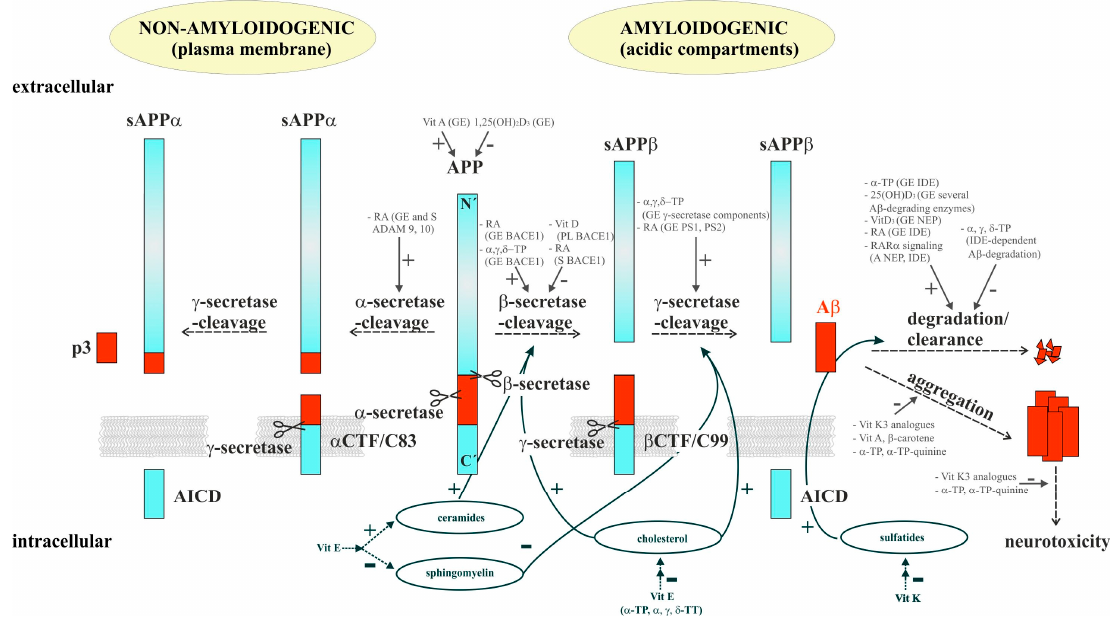
Figure 1. Proteolytic processing of the amyloid precursor protein (APP) and its modulation by vitamins A, D, E, and K. APP can be cleaved in two different processing pathways. In the amyloidogenic processing pathway ( right ) APP is first cleaved by β -secretase BACE1 ( β -site APP cleaving enzyme 1) generating soluble sAPP β (soluble β -secreted APP) and the C-terminal anchored fragment C99/ β CTF ( β -cleaved C-terminal fragment), which is further cleaved by the γ -secretase complex to release amyloid- β (A β ) peptides. A β peptides can be degraded by several processes or aggregate to build up neurotoxic amyloid plaques. In the non-amyloidogenic pathway ( left ) APP is first cleaved within the A β domain by α -secretases (members of the ADAM (a disintegrin and metalloprotease) protein family) leading to the release of soluble sAPP α (soluble α -secreted APP) and the generation of the C-terminal membrane-tethered fragment C83/ α -CTF ( α -cleaved C-terminal fragment), which is also cleaved by the γ -secretase complex to release the non-toxic peptide p3. In both processing pathways the APP intracellular domain (AICD) is liberated into the cytosol. GE = gene expression; S = sorting; A = activity; RA = retinoic acid; Vit = vitamin; TP = tocopherol; PL = protein level; TT = tocotrienol; PS1 = presenilin 1; PS2 = presenilin 2; IDE = insulin degrading enzyme; NEP = neprilysin. The effects of vitamins on AD-relevant mechanisms are indicated by solid arrows, the impact of vitamins on lipid homeostasis is delineated by dashed arrows. + = increase; − = decrease.